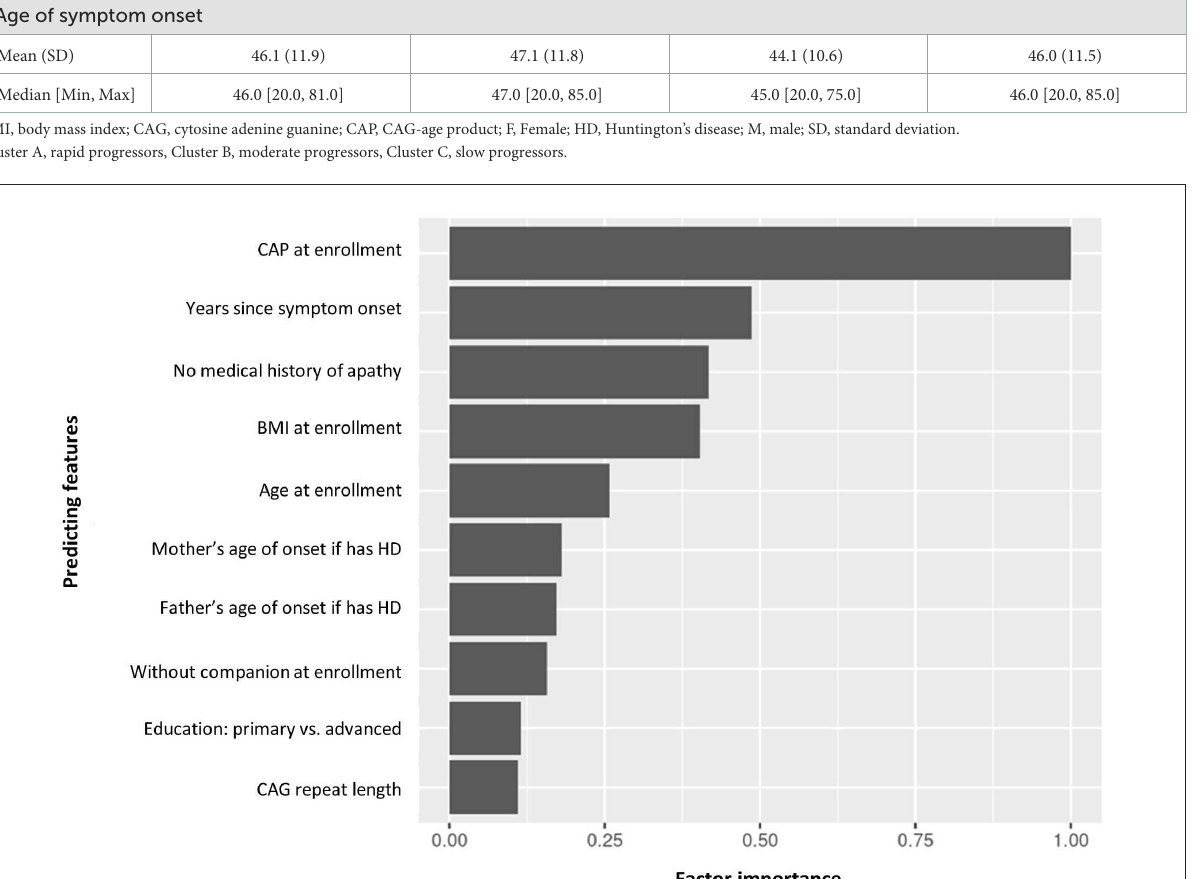
and CAG repeat length (included in the top 10 features in our study) (12). Whilst a principal component analysis approach is a good way to reduce multidimensional data, it is